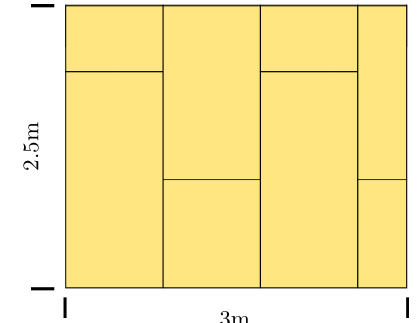
Figure 2: Dimensions of the robot arena.